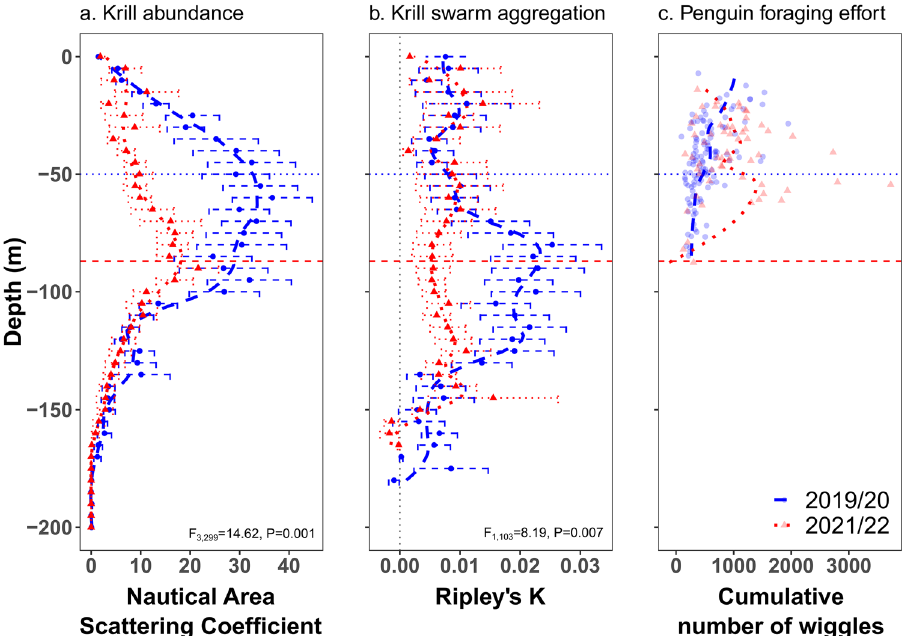
Figure 3. Mean ± s.e. vertical distribution of Antarctic krill ( Euphausia superba ) acoustic density( a ), Mean ± s.d. Ripley’s K coefficients for measuring krill swarms vertical aggregation ( b ) and vertical foraging effort of chinstrap penguins ( c ) at Harmony Point, Nelson Island, in two seasons with contrasting environmental conditions. Horizontal lines indicate the depths of krill biomass peaks in 2019/20 (blue dotted line) and 2021/22 (red dashed line). Vertical grey dotted line indicates the biomass threshold for comparing depths in both seasons ( a ) and 0 Ripley´s K ( b ). Ripley’s K ( b ) positive values indicate aggregation of swarms, values equal to zero indicate that swarms were randomly distributed, and negative values indicate dispersed or patchier swarms. Bottom phase mean dive depth of each foraging trip and the total number of wiggles per foraging trip ( c ). Statistical results from Permutational Analysis of Variance (999